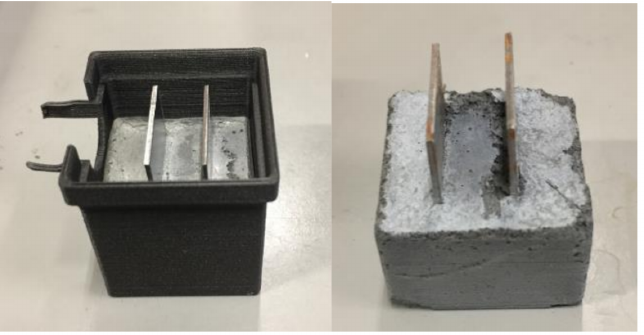
Figure 1. Photography of sample in the 3D printed mold and sample removed from the